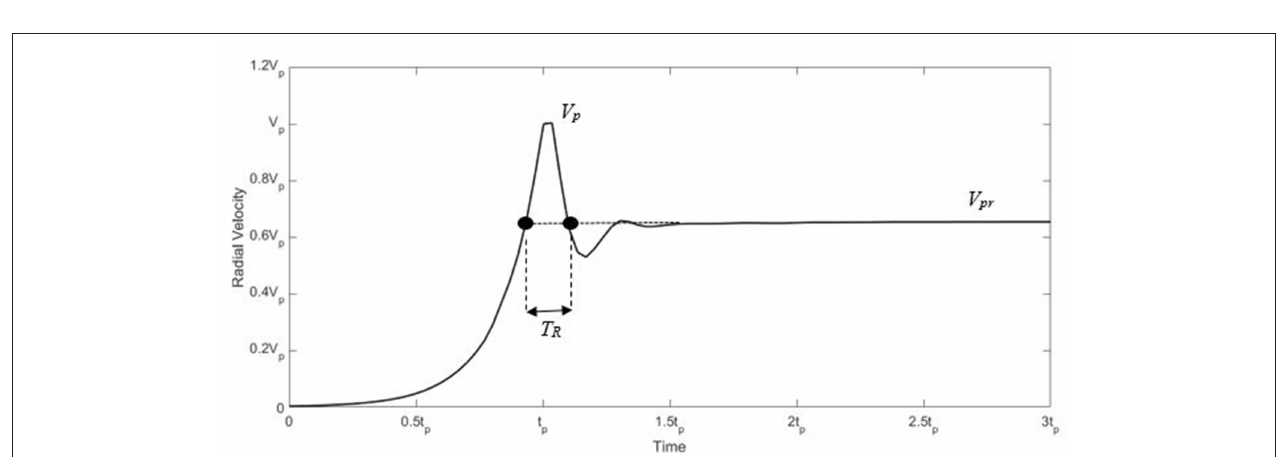
FIGURE 10 | Time history of longitudinal reaction for turbulent wind field compared to fully correlated wind field.